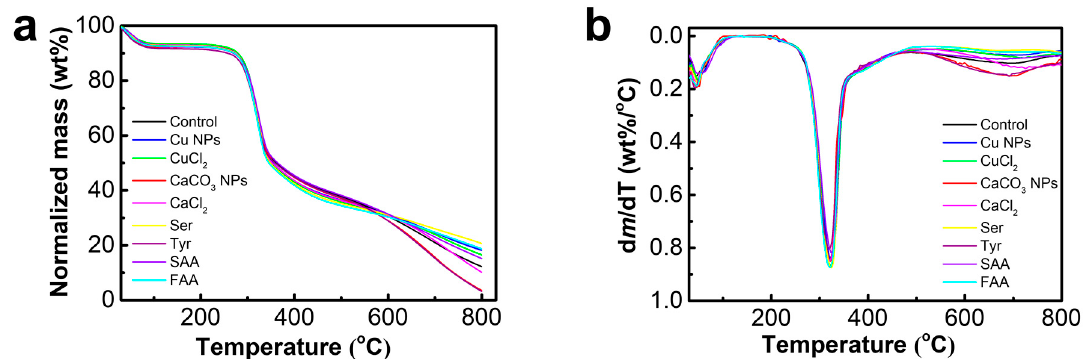
Figure 3. TGA results of silk fibers. ( a ) TG curves; ( b ) DTG curves.